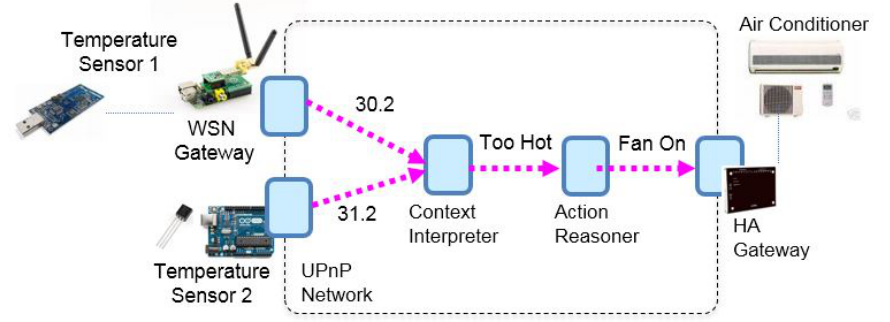
Figure 2. An air conditioning service in a UPnP-based home network. The dotted lines with arrowhead indicate logical data flows, which are mediated by a service manager under the